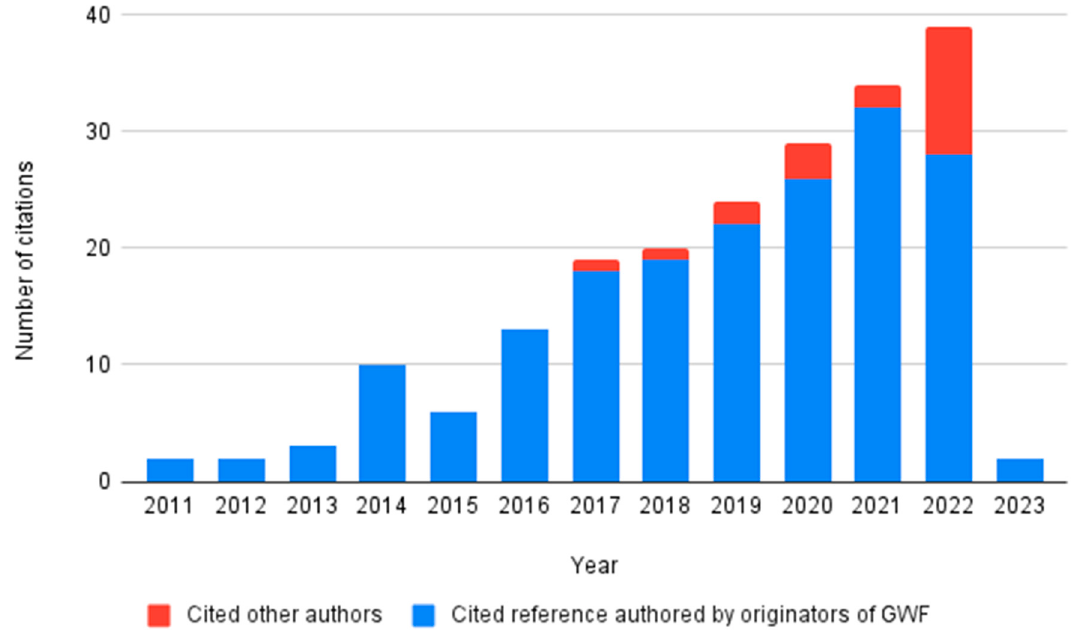
Figure 2. Cited reference authored by the originators of the GWF and by other authors.